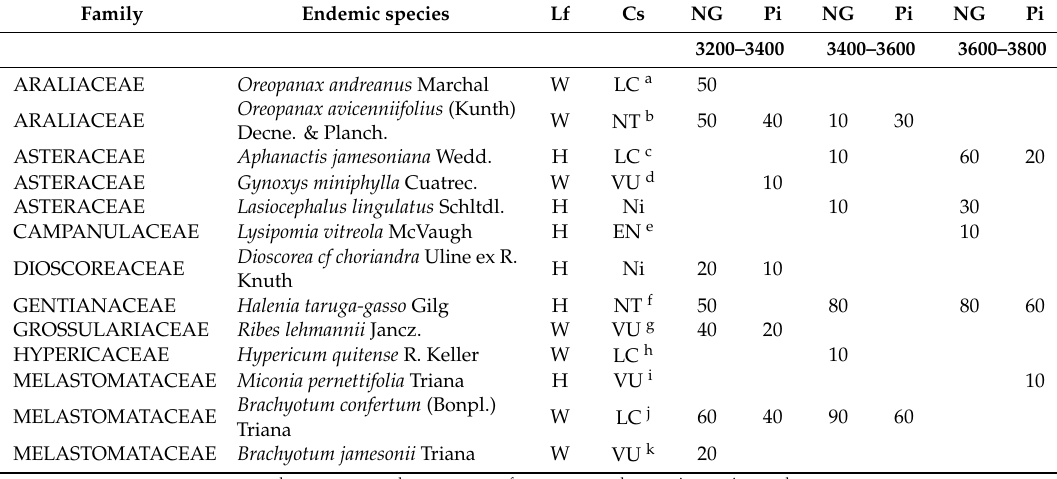
Table 4. List of endemic species with their percentage of occurrence in the plots at natural grassland (NG) and pine plantation (Pi) sites in three di ff erent elevational ranges in m a.s.l. (Total 30 plots for herbaceous plants for each vegetation cover, and 20 plots for woody plants for each vegetation cover). Lf = life form, Cs = conservation status according to the IUCN Red List of Threatened Species [57], H = herbaceous plant, W = woody plant. LC = least concern, NT = near threatened, VU = vulnerable, Ni = not included in the Red List, EN = endangered.